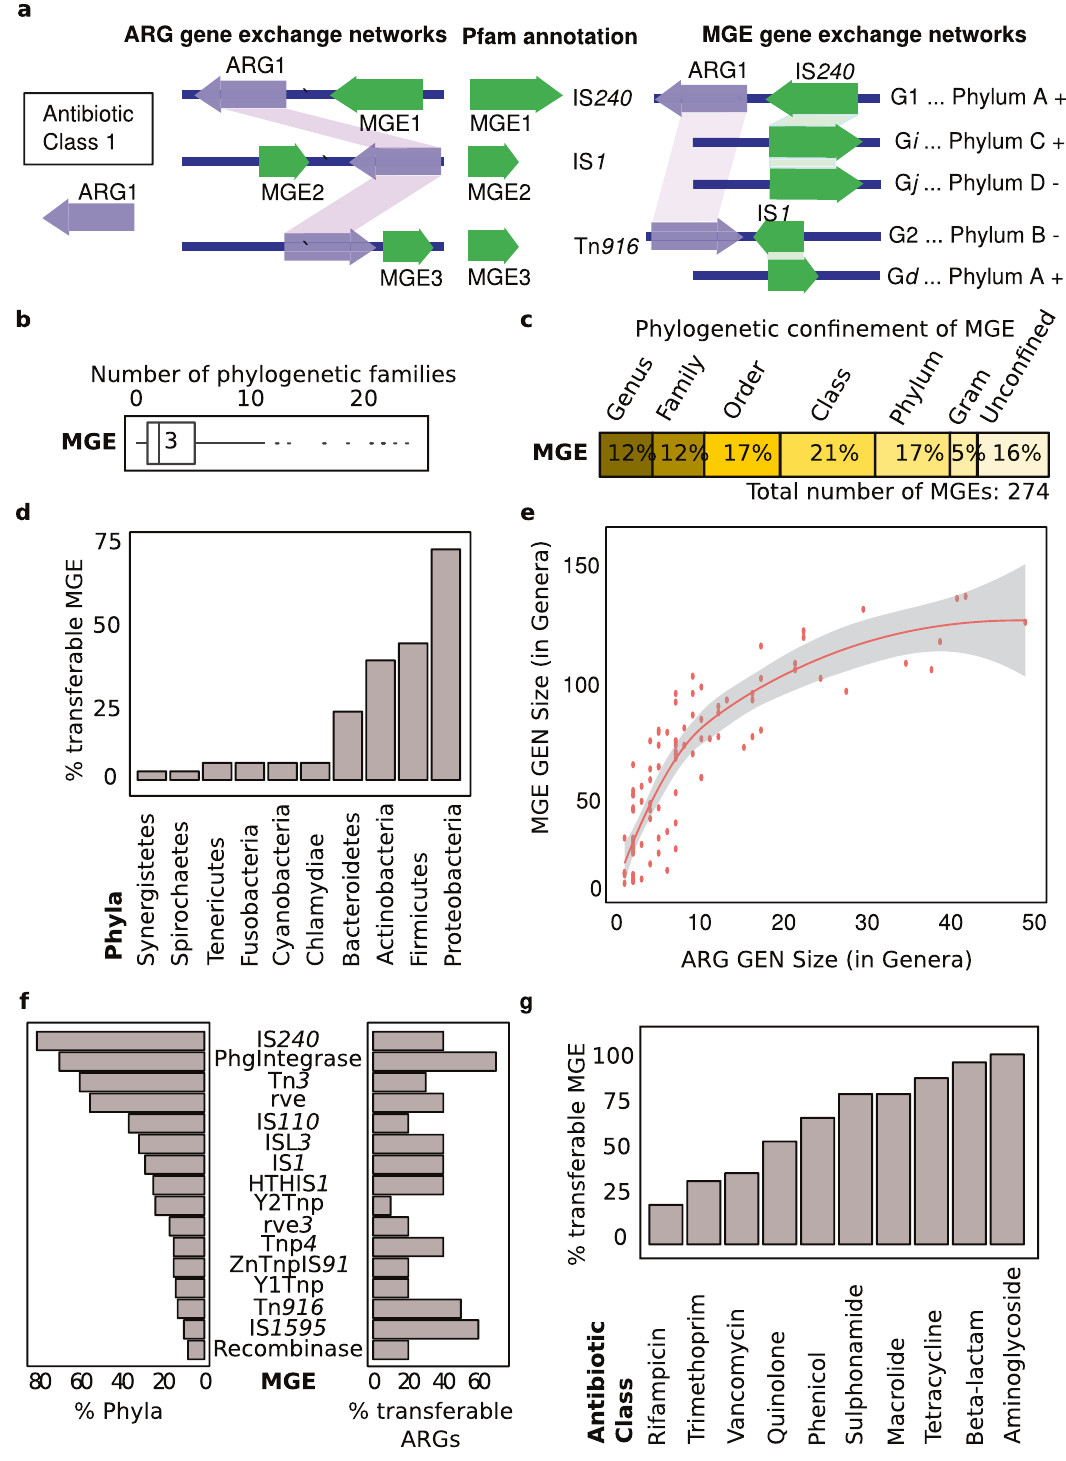
Fig. 2 Mobile genetic elements (MGEs) in gene exchange networks (GENs). a Conceptual guide to show how we extracted the mobile genetic elements from the ARG neighboring regions, annotated them using Pfam, and identi fi ed the MGE gene exchange network. b Distribution of MGEs based on phylogenetic families that participated in dissemination. Box, range of number of families; line and number, median; dots, outliers. c Distribution of phylogenetic con fi nement of MGEs. Percents of MGEs con fi ned to a certain phylogenetic classi fi cation. d Percents of total MGEs that were observed in indicated phyla. e Distribution of ARG GEN size (as number of genera) versus associated MGE GEN size. Red line, mean values; shaded area, erorr bands as mean values + / − SEM. f Dissemination of MGEs across microbial phyla and their association with transferable ARGs observed in their neighbourhood. To left, n = number of phyla with a given MGE over seven phyla participating in ARGs gene exchange networks. To right, n = number of transferable ARGs neighbouring a given MGE over the total number of transferable ARGs (152 ARGs). g Percentage of MGEs associated with ARGs by antibiotic class to which resistance is conferred. Source data are provided in Supplementary Data 1, 3, 5, and 14.